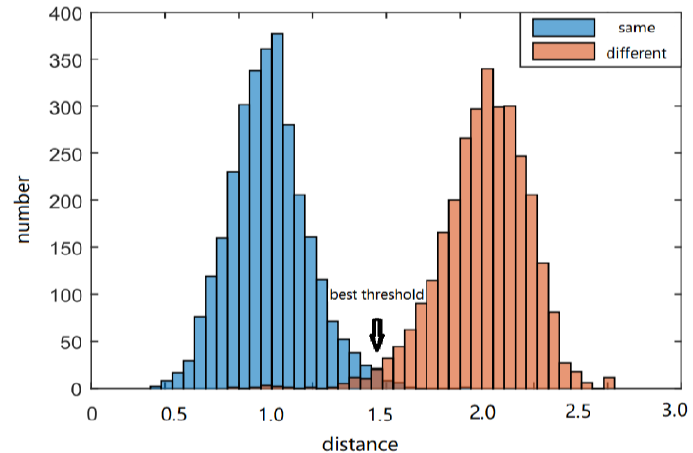
Figure 9. The histogram of LFW verification pairs.